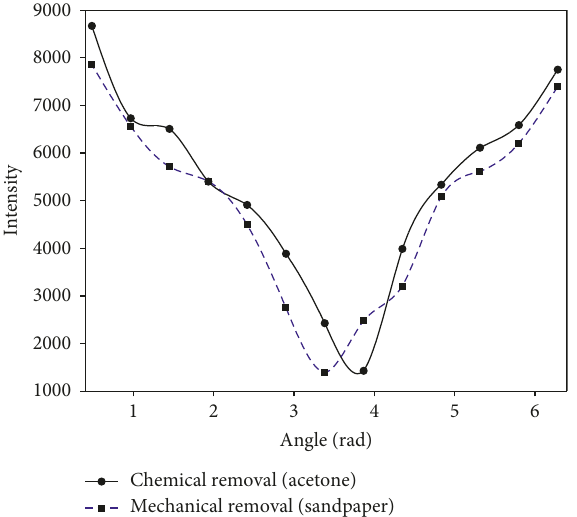
Figure 10: Radial distribution of maximum side-illumination of PGR-FB750 specimen after chemical and mechanical